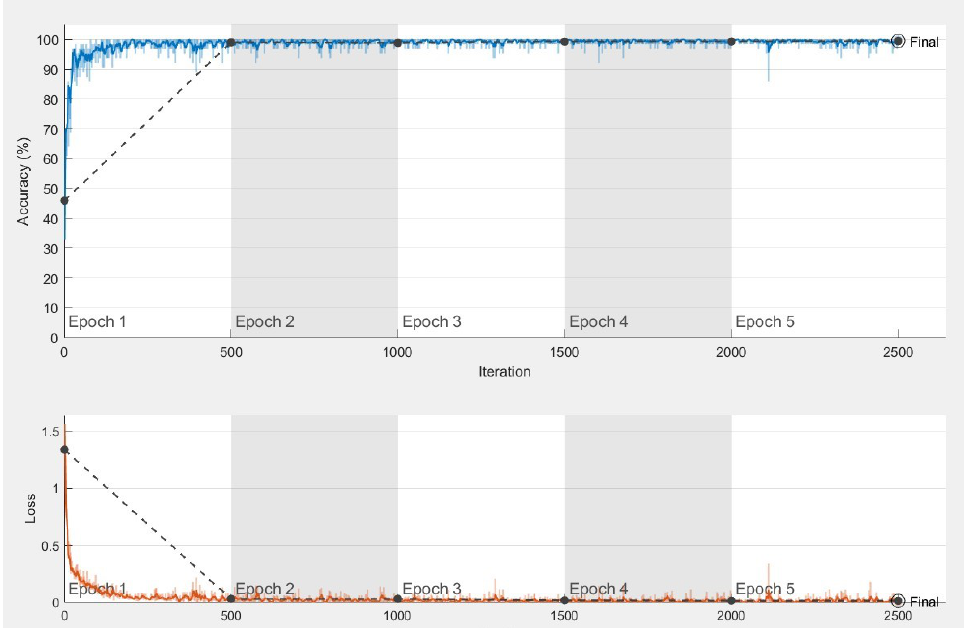
Figure 5. VB-DCNN Training for Case-II.